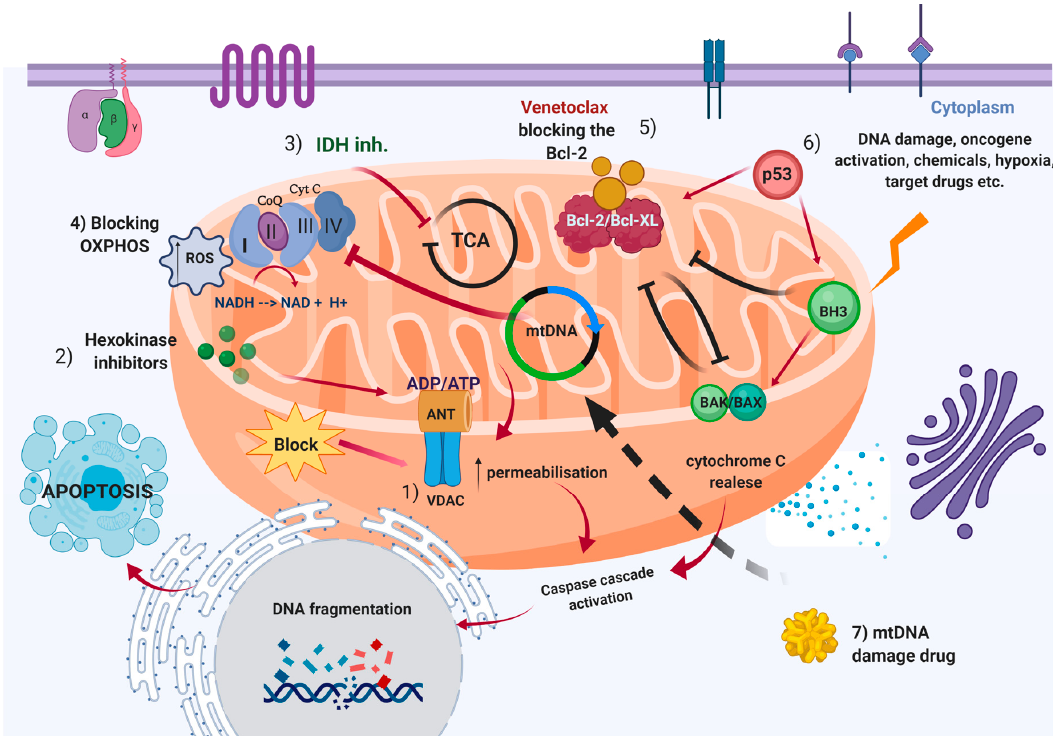
Figure 2. General overview of the mitochondrial targeted therapy approach. ( 1 ) Blocking VDAC selective permeability and activation of caspase cascade; ( 2 ) Hexokinase inhibitors block the enzyme hexokinase and ADP/ATP production; ( 3 ) IDH inhibitors manifest their activity inhibiting the α -ketoglutarate production in TCA; ( 4 ) Impaired OXPHOS and hyperproduction of ROS lead to cell death; ( 5 ) Using BCl-2 family proteins as targeted activation of intrinsic apoptotic pathways through the example of drug Venetoclax. Venetoclax releases the anti-apoptotic inhibition of Bcl-2 over BAX and BAK and then cytochrome c activiate the caspase cascade. In addition, as a response to extern stimuli or by drug, ( 6 ) p53 can be activated directly or in collaboration with the BH-3 only proteins can trigger the BAK/BAX pro-apoptotic activity. (7) mtDNA can be a core of action of drugs (such as bleomycin) which are producing damage in the DNA coding sequences and thereafter impaired cell function and death. (Picture created with Biorender.com).